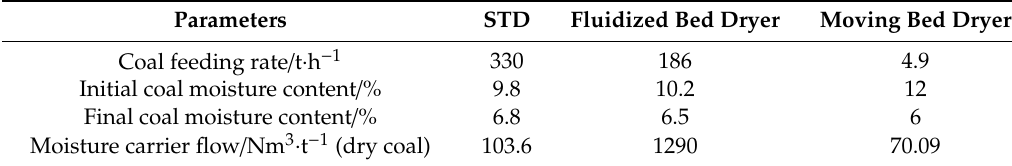
Table 4. Benefit assessment of STD (Steam Tube Dryer), fluidized bed and moving bed dryer